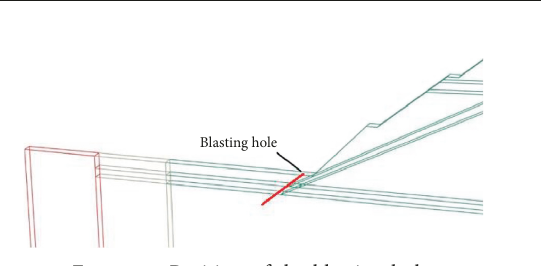
Figure 5: Position of the blasting hole.